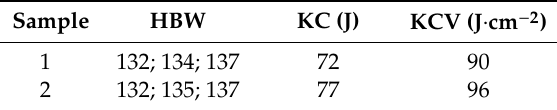
Table 3. Brinell hardness and impact toughness.